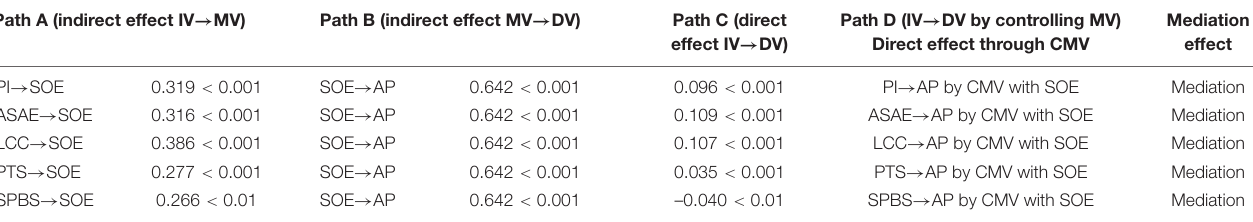
TABLE 9 | Mediation effects between predictors related with stakeholders’ participation, goal directness and learning climate of the classroom with students’ academic performance through their engagement in studies as mediation variable ( N = 2,758). Path A (indirect effect IV →